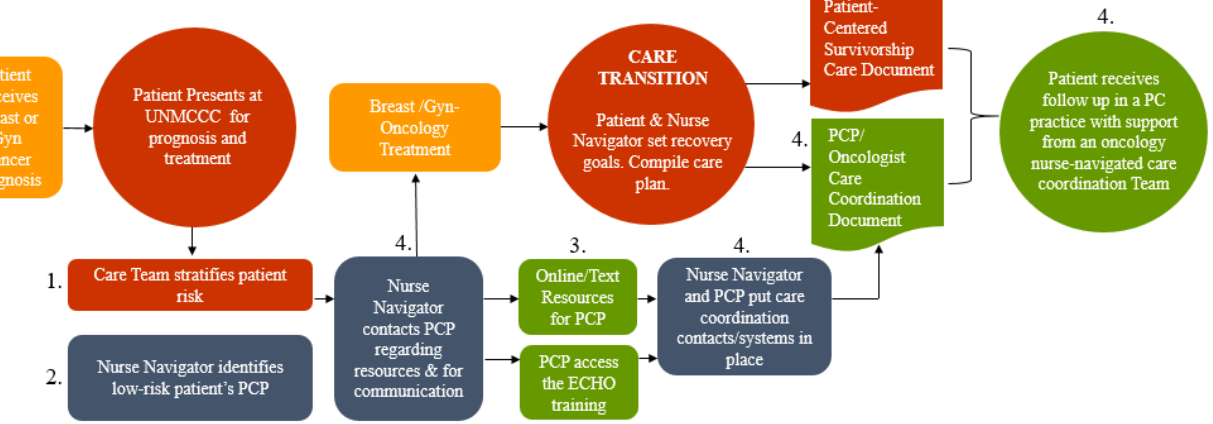
Figure 1. Oncology and Primary Care Provider Care Coordination Model.